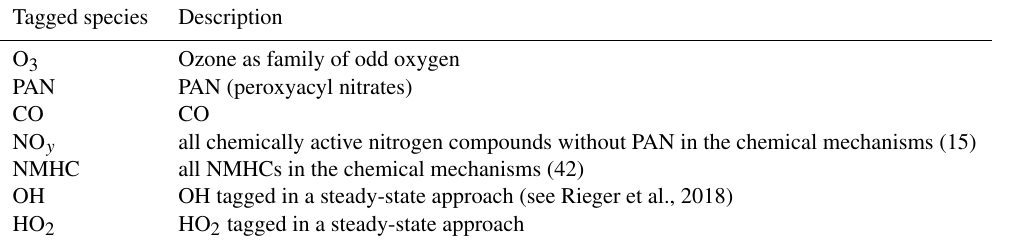
Table 4. Definition of the chemical families used in the tagging method. More details on the species contained in the families are given in the Supplement of Grewe et al.